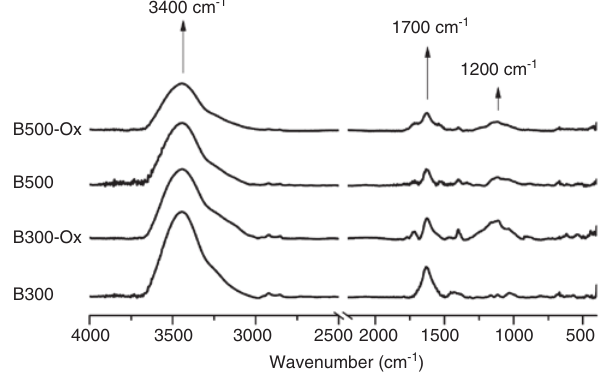
Figure 2: Diffuse reflectance infrared Fourier-transformed (DRIFT) spectra of biochars and oxidized